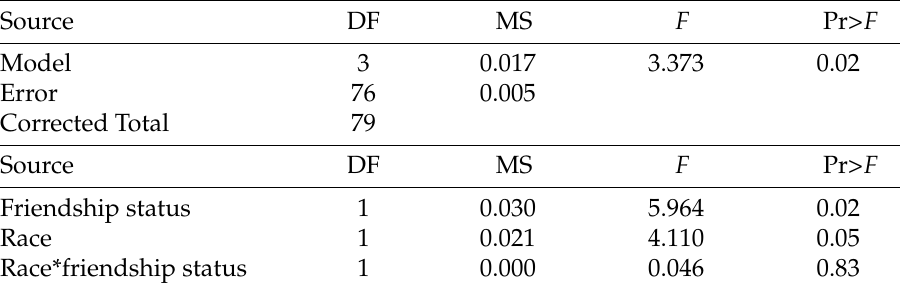
Table 3: Experiment 1 analysis of variance, role-taking accuracy by friendship status, race, and race composition of the dyad